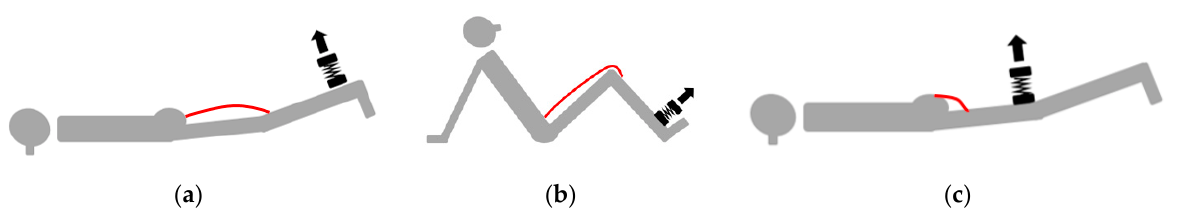
Figure 3. Maximum voluntary contraction (MVC) experimental design for the ( a ) hamstrings, ( b ) quadriceps and ( c ) glutes.